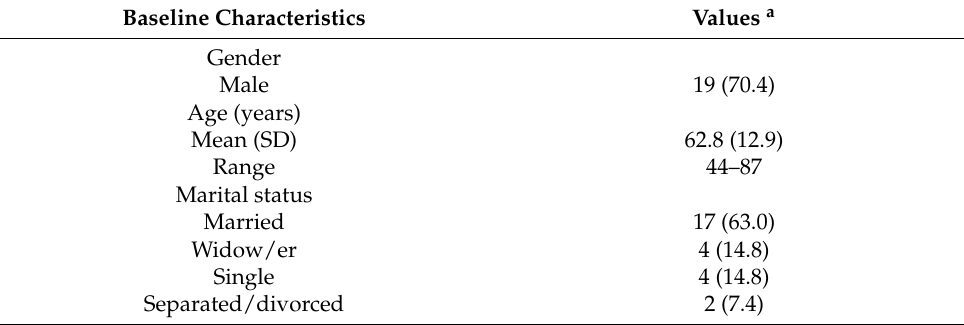
Table 1. Characteristics of the study population at initial assessment ( n =